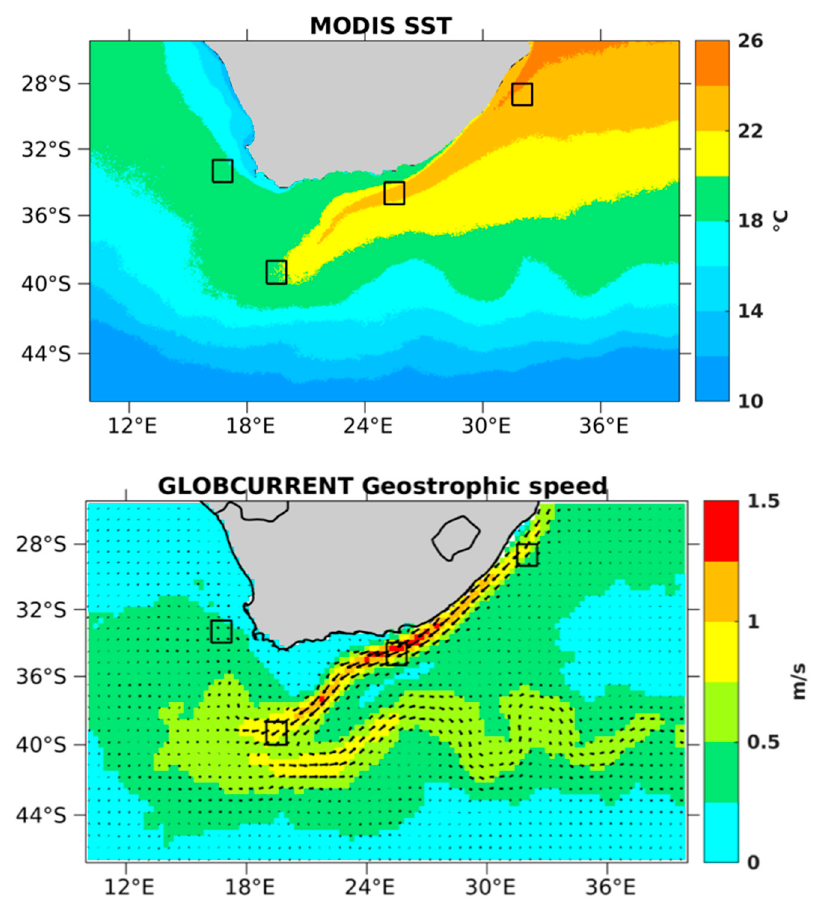
Figure 1. ( Top ) Moderate Resolution Imaging Spectroradiometer (MODIS) surface temperature (SST) (°C) annually averaged from 2003 to 2007 and ( bottom ) GlobCurrent geostrophic current speed (colour) and direction (arrows) at 0 m depth. Black squares represent the four locations of time series used in the study: three regions in the Agulhas system: off Durban (31.5–32.5°E; 30–31°S), off Port Elizabeth (25–26°E; 34.5–35.5°S) and in the Agulhas Retroflection (19–20°E; 38–39°S), and one point off Cape Town (16–17°E; 33.5–34.5°S).